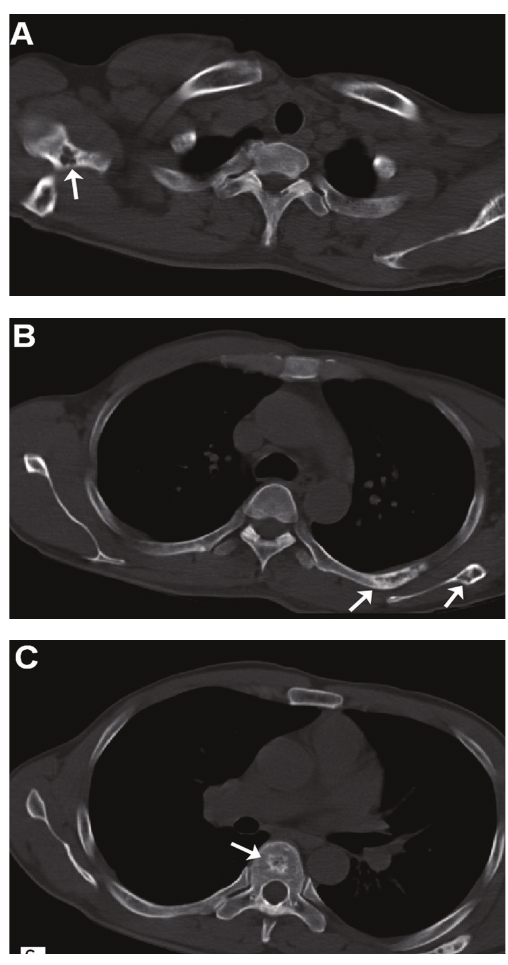
Figure 3: Chest CT of bone window showed eroded bone destruc- tion with sclerotic edge in scapulas and ribs ((A): right scapula; (B): left scapula and the left 5th posterior rib) and patchy high density in thoracic vertebrae (C) However, the amount of the lesions was greater than that in Tc-99m MDP WBBS within the corresponding thoracic area. The bone lesions on CT with intensive Tc-99m MDP accumulation prompted multiple bone